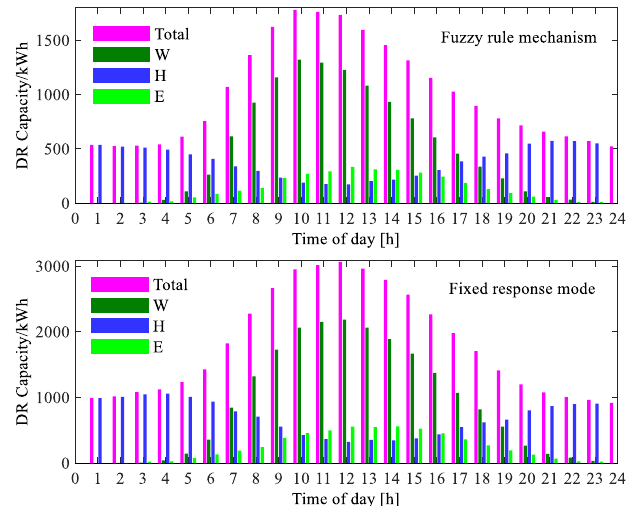
Figure 11. EVA-DR capacity expectation with different mechanism.